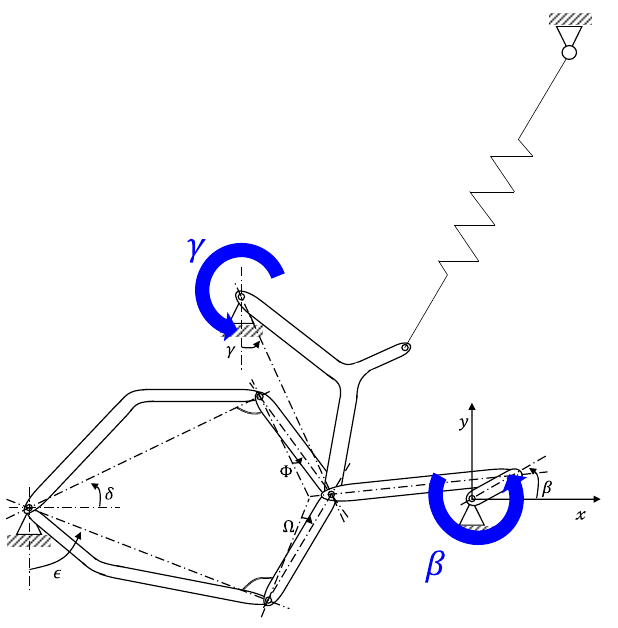
Figure 7. Generalized coordinates β and γ of the multibody system.